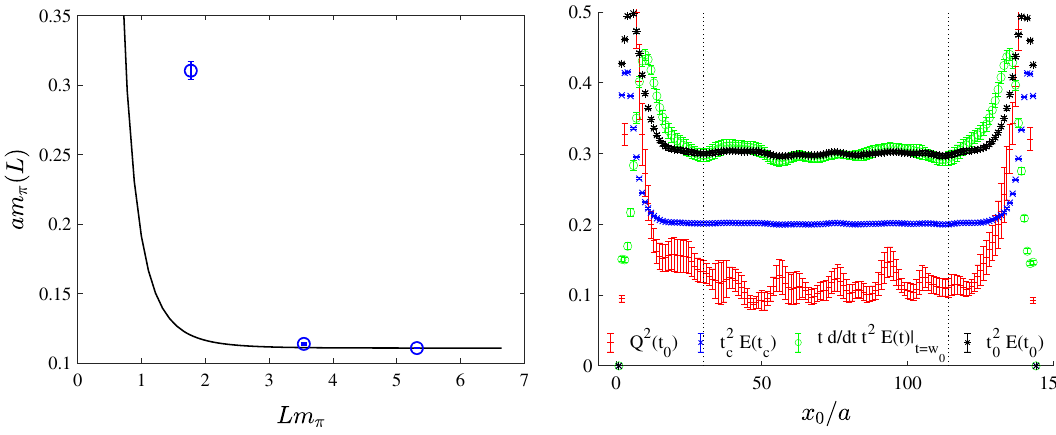
(cid:25) (cid:25) , t )/ 2 / E ( x Q 2 ( x 0 , t 0 ) , red plusses) 0 0 x 0 x 0 0